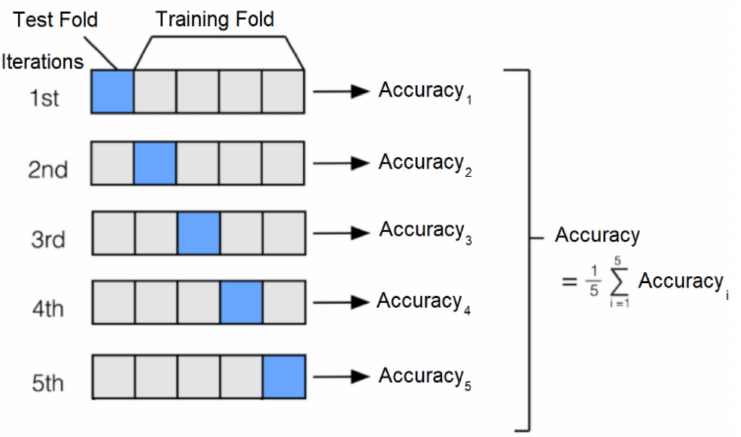
Figure 8. K-fold cross-validation